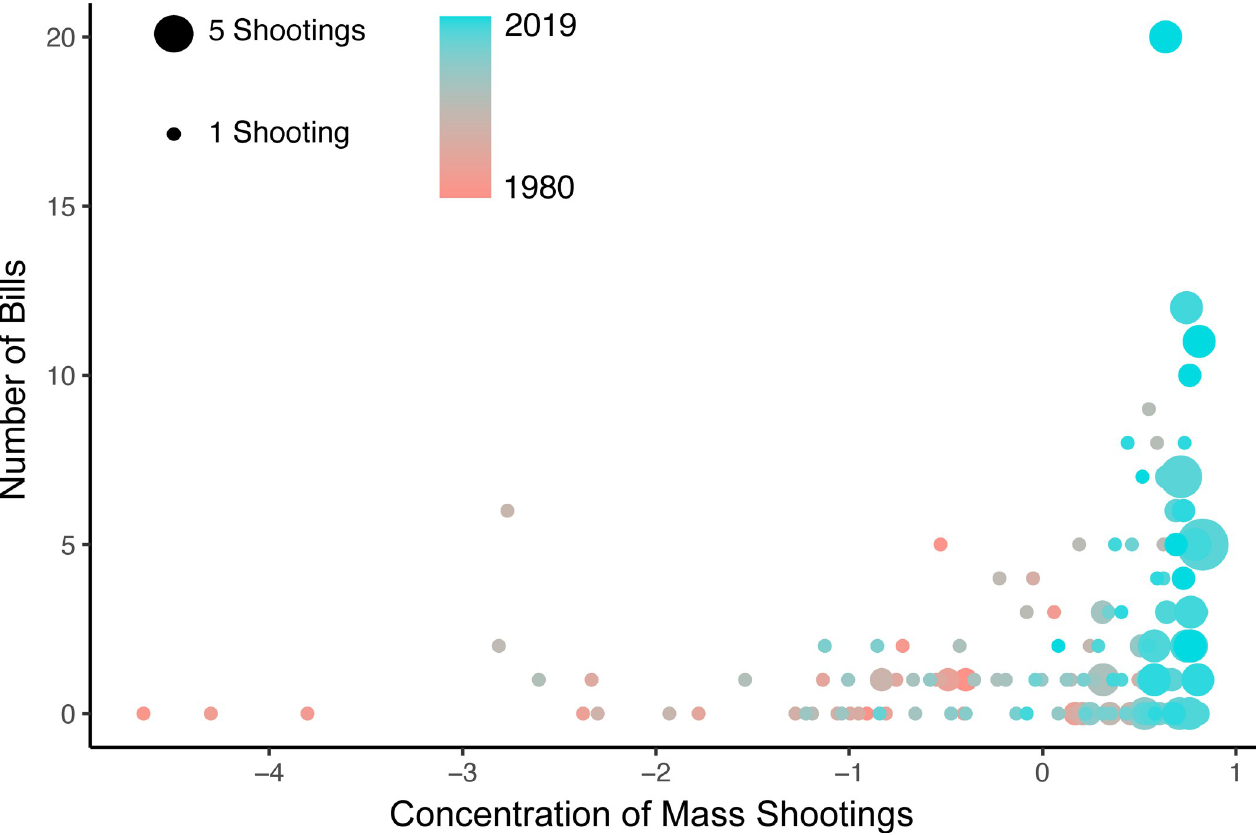
Fig 1. How gun control bills relate to frequency and concentration of mass shootings � . � Node size is number of shootings in a month. Node color is year. Concentration is a standardized index where higher values indicate fewer average days between shootings.